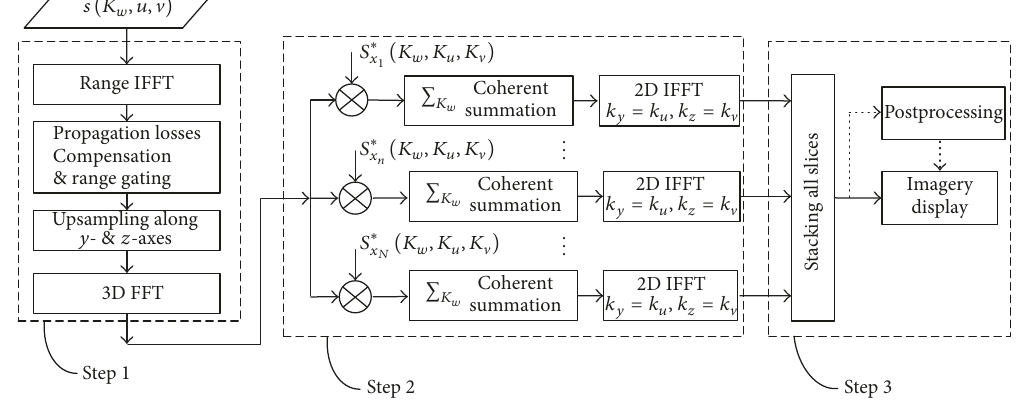
Figure 2: Flowchart of 3D range stacking algorithm for concealed weapon